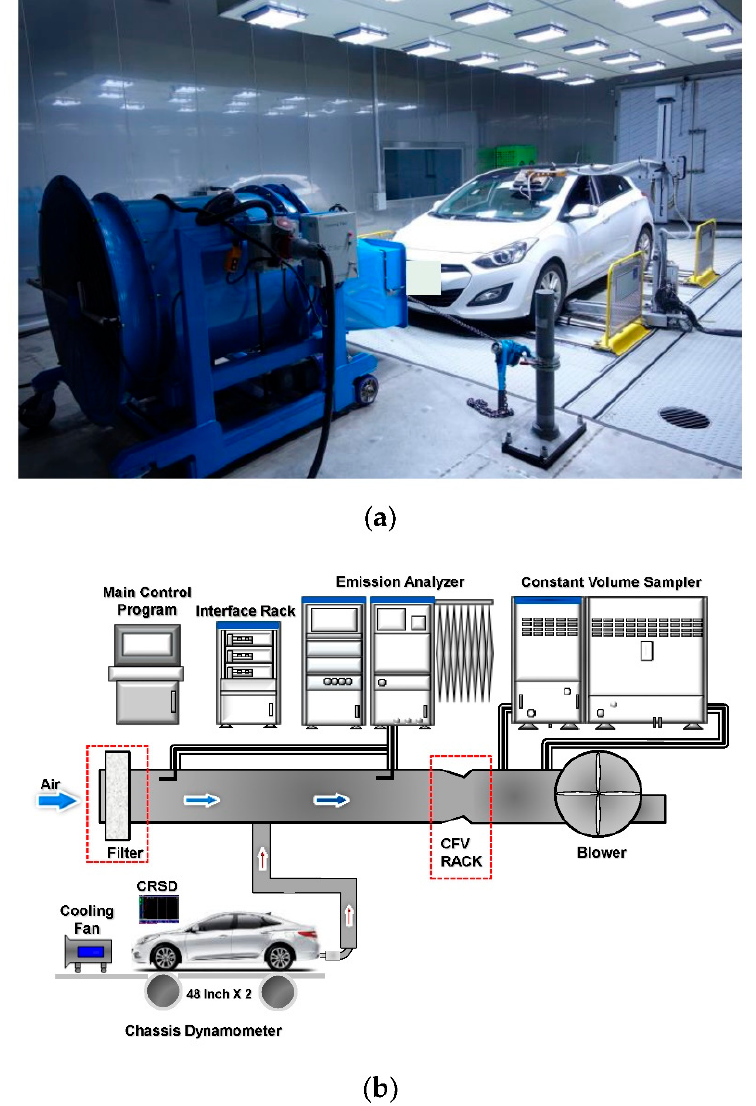
Figure 1. Experimental apparatus: ( a ) Picture of emission test system using chassis dynamometer and ( b ) its schematic. Table 4. Specifications of test dynamometer.